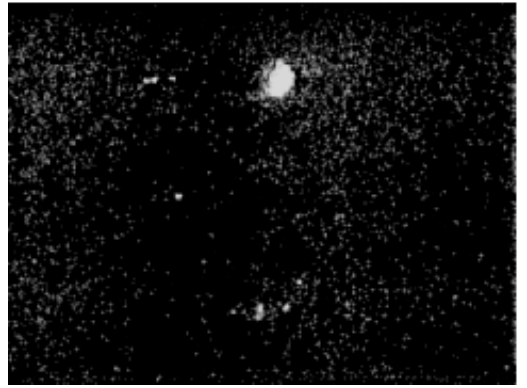
Fig. 7 – Image of crystalline lens without the background il- lumination, only the laser beam is seen at the electrode tip and leaving the lens. This frame was taken before the application of the current pulse.